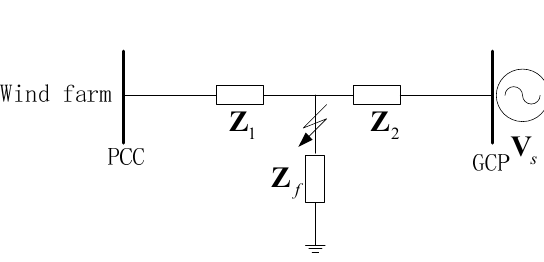
Figure 1. Voltage-divider